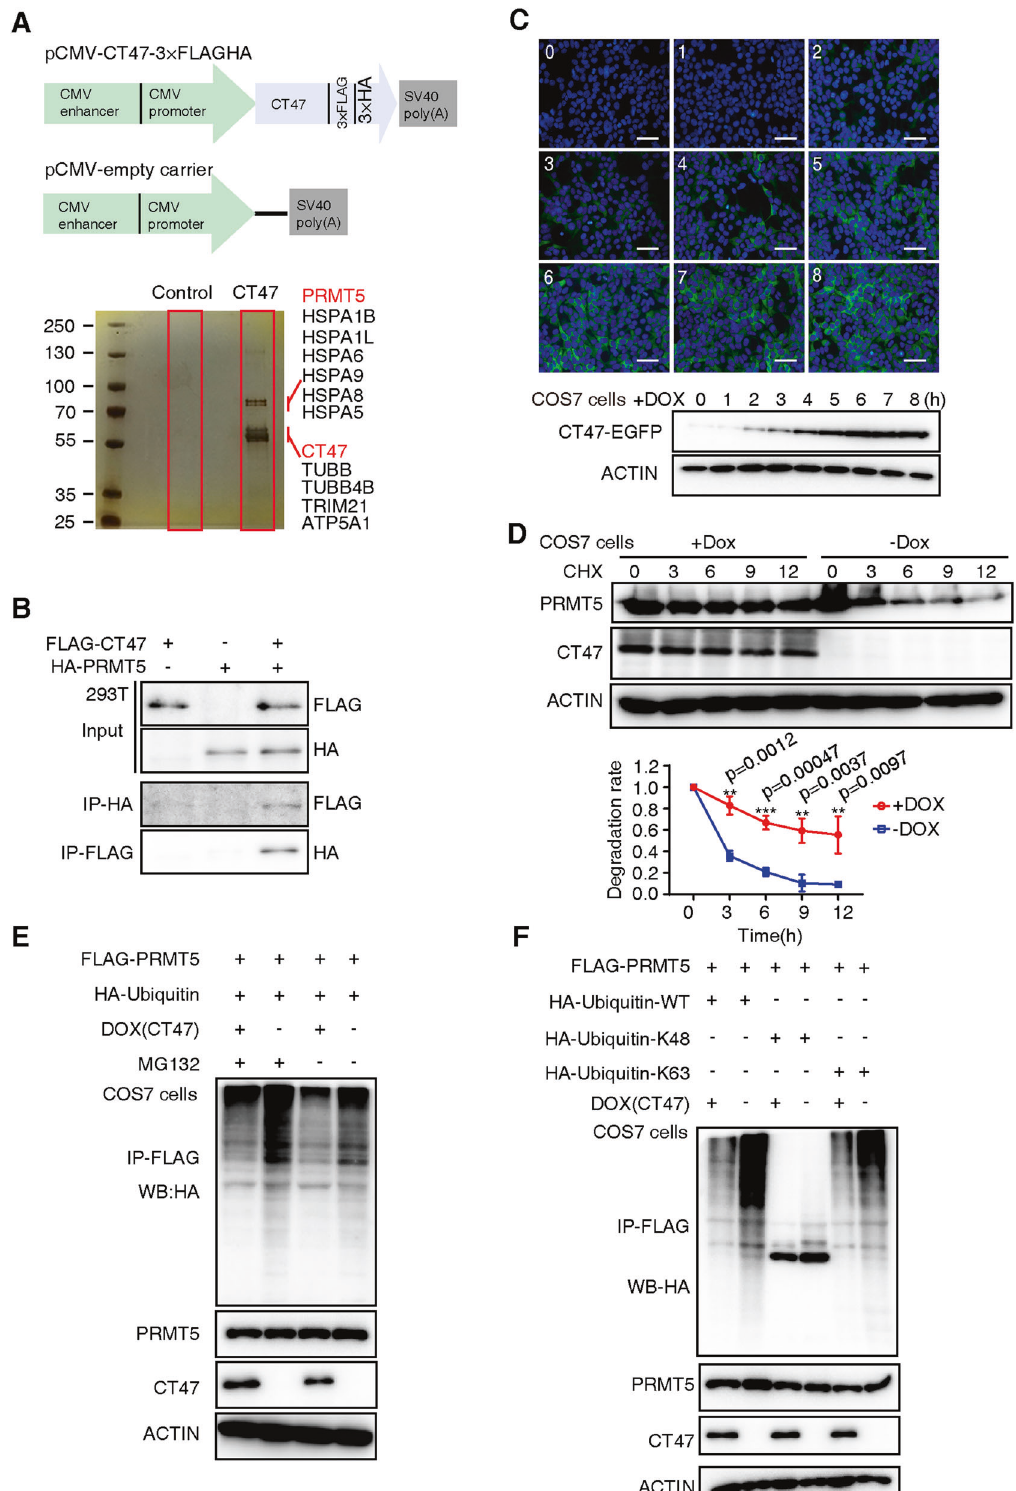
immunostaining with peanut agglutinin (PNA) lectin, a marker for the acrosome, it was clear that CT47 -BAC testes had almost no round spermatids compared with wild-type (WT) mice (Fig. 3C, D). These results together with histological analysis (Fig. 2G, H) indicate that CT47 expression in testes speci fi cally caused spermatogenesis arrest at meiotic prophase